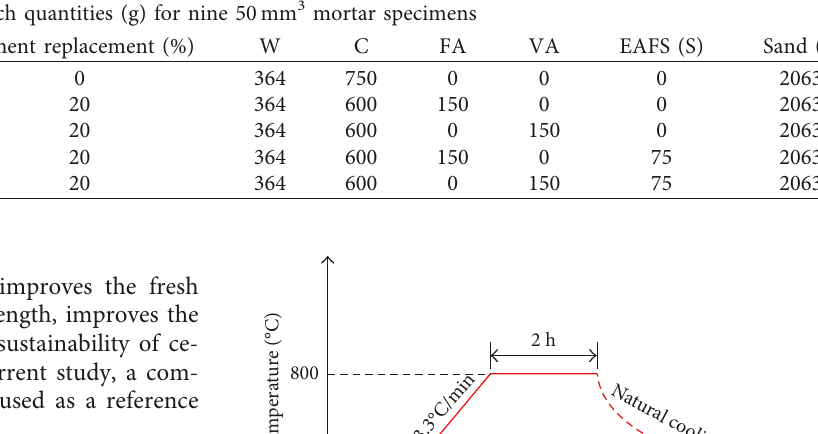
0.485; cm :s 1 :2.75). (cid:30) (cid:30)